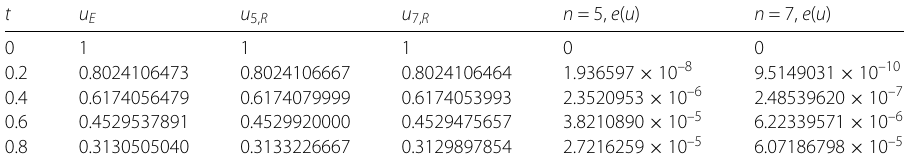
Table 3 Numerical result of Example 5.2